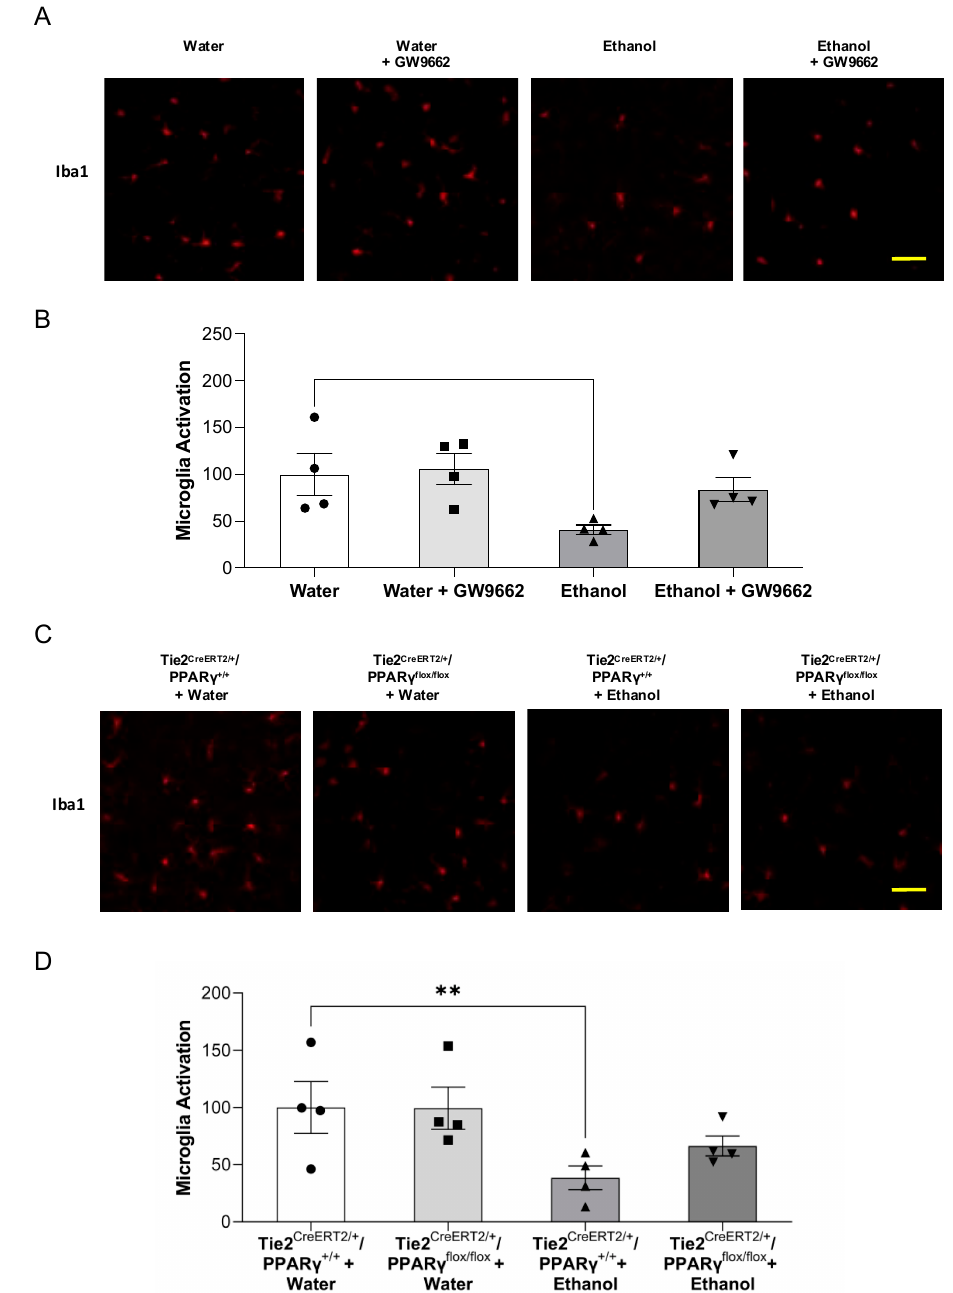
Figure 6. Effect of chronic ethanol consumption on microglia activation in the presence and absence of GW9662 and endothelial-specific conditional PPAR γ knockout. ( A , C ) Representative immunohistochemistry staining of Iba1 (scale bar = 100 μ m). ( B , D ) Values are means ± SE. ** p < 0.05 vs. Water or Tie2 CreERT2/+ /PPAR γ +/+ + Water. Analyzed using two-way ANOVA with Tukey’s post hoc.